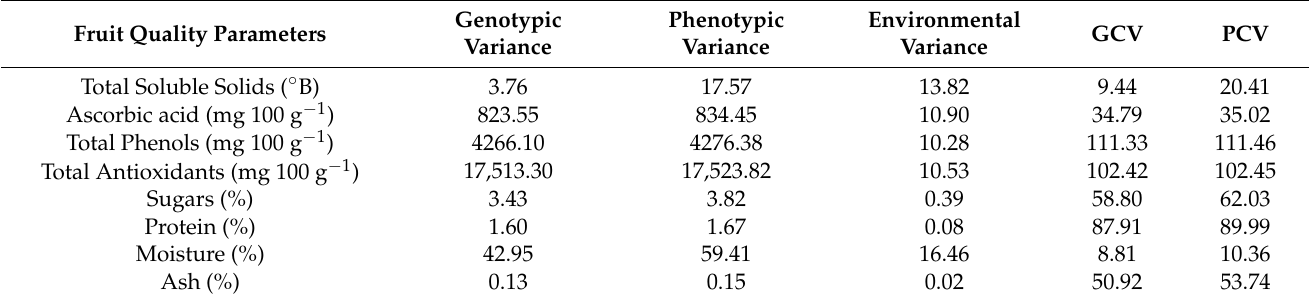
Table 4. Values of variance and coefficients of variation of the fruit quality parameters determined for the fruits of 18 Jujube genotypes in the two-year study period.